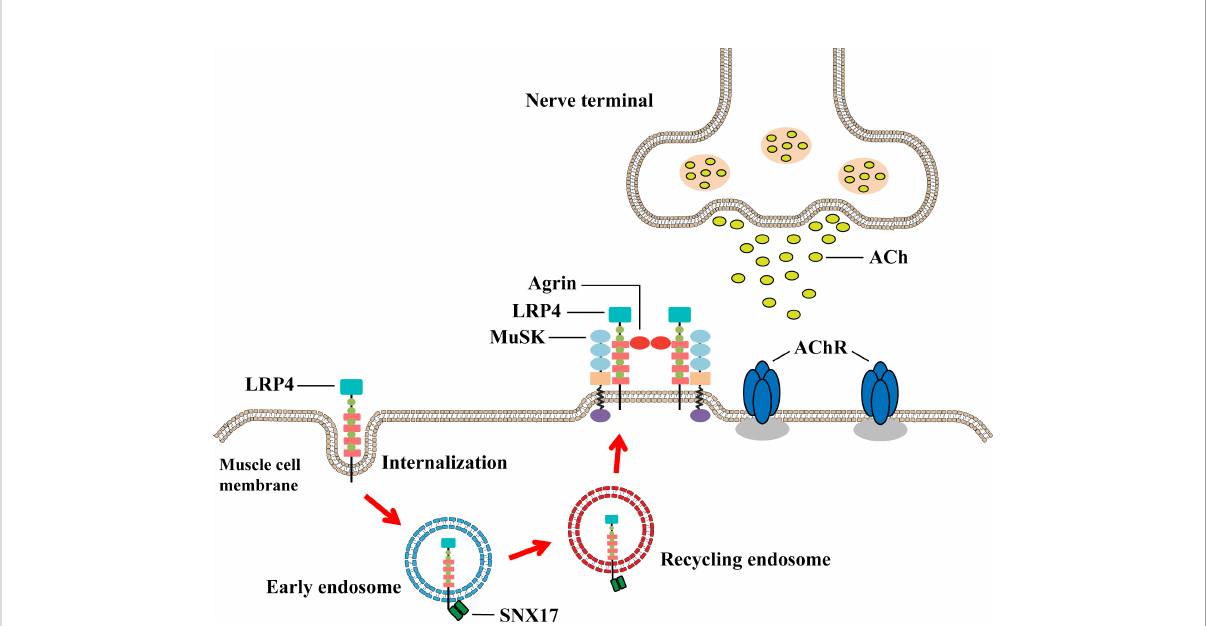
FIGURE 7 Underlying mechanism by which SNX17 increases cell surface LRP4 expression to promote AChR aggregation and neuromuscular excitatory transmission restoration. SNX17 recognizes and binds LRP4 that is internalized into early endosomes and mediates the transformation of LRP4 to circulating endosomes and then back to the muscle cell membrane. LRP4 returning to the membrane induces AChR aggregation through the Agrin – LRP4 – MuSK signaling pathway, which binds ACh released from the presynaptic membrane and further restores the neuromuscular excitation transmission. AChR, acetylcholine receptor; LRP4, low-density lipoprotein receptor-related protein 4; MuSK, muscle-speci fi c receptor tyrosine kinase; NMJ, neuromuscular junction; SNX17, sorting nexin